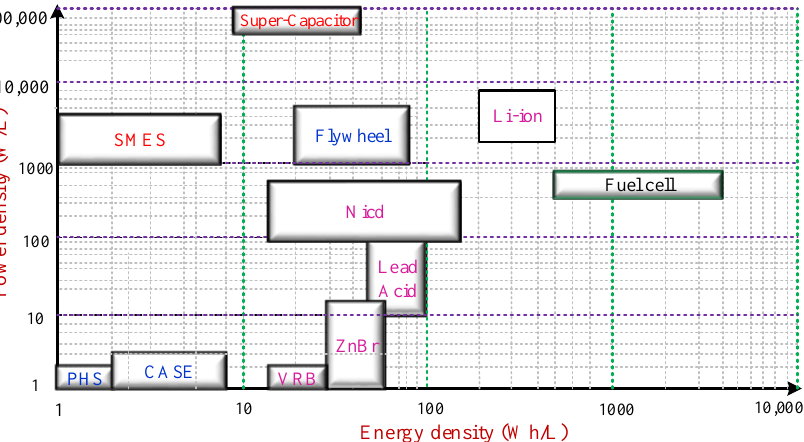
Figure 4. Classification of common forms of energy storage in terms of power and energy density.